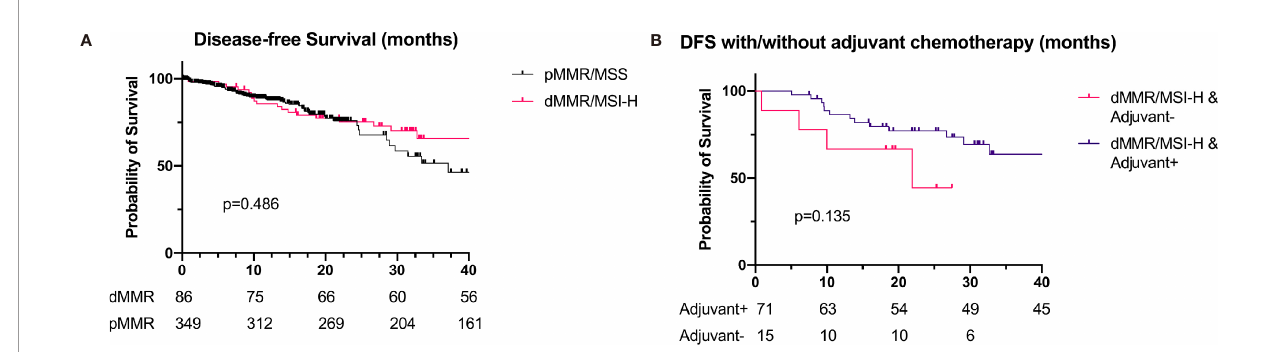
FIGURE 3 | Survival of patients with dMMR/MSI-H (n = 86) and pMMR (n = 349) at stage II and III. (A) DFS of patients with dMMR/MSI-H and pMMR (46.9 vs . 37.1 months, p = 0.486). (B) DFS of dMMR/MSI-H patients with/without adjuvant chemotherapy (46.9 vs . 21.9 months, p = 0.135). dMMR, de fi cient DNA mismatch repair; MSI-H, microsatellite instability-high; pMMR, pro fi cient mismatch repair; DFS, disease-free